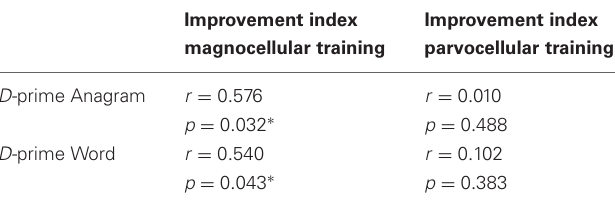
Table 4 | Pearson correlations between an improvement variable for performance on visual training and a d -prime variable for performance on a lexical decision task